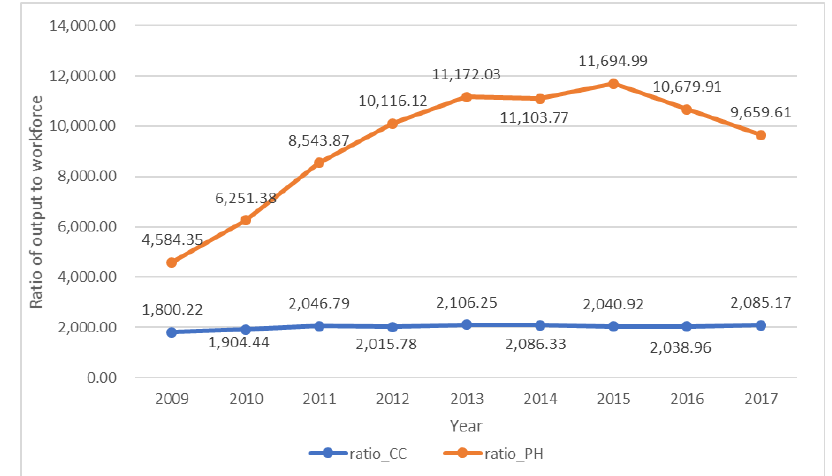
Figure A1. Trends in output – workforce relationship for clinical care and public health services.